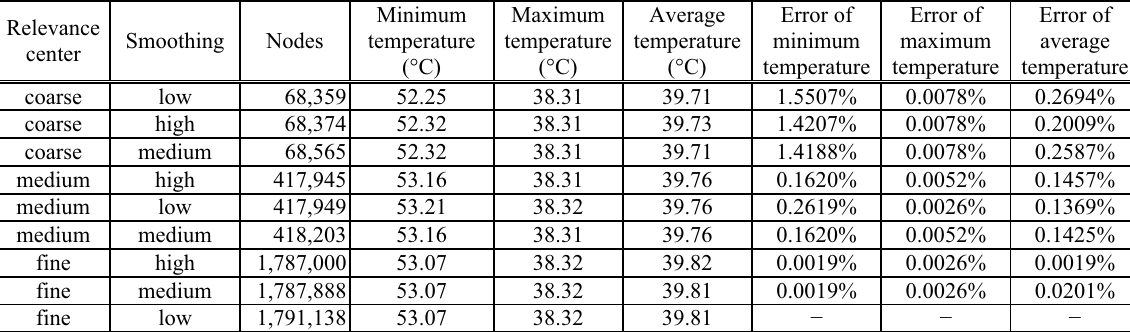
Table 4. Results of a preliminary experiment on primary sizing